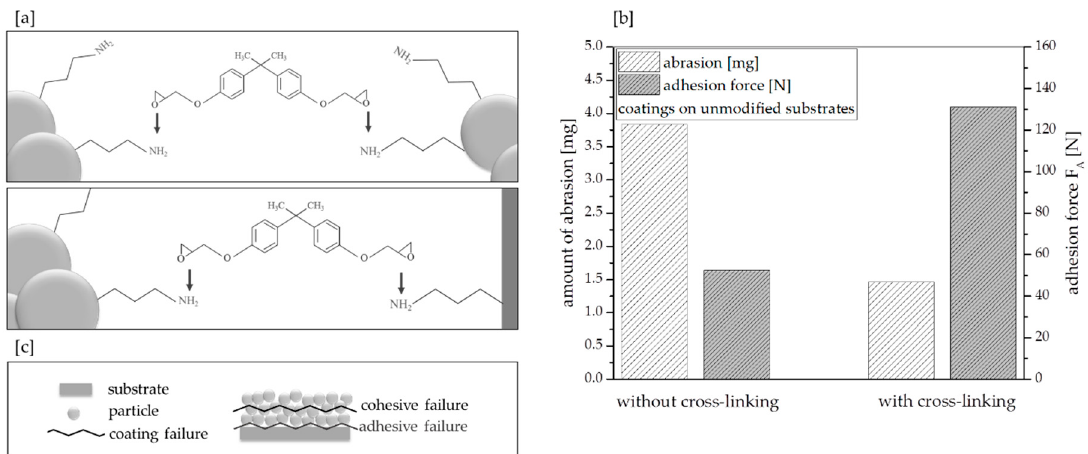
Figure 1. Cross-linking between particles as well as between particle and modified substrate ( a ); amount of abrasion and adhesion force of coatings with and without cross-linking ( b ); kind of failure during adhesion measurement ( c ).